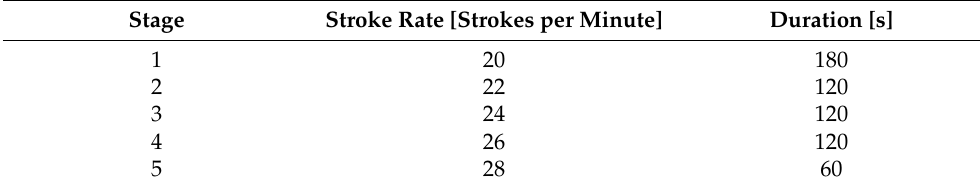
Table 3. Load stages for five-stage rowing training.